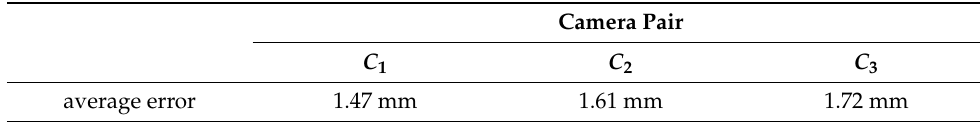
Figure 6. 3D reconstruction result and error. ( a ) reconstruction point cloud matched with the laser point cloud. ( b ) the corresponding point distance error maps, the units in the diagram are in mm. Table 4. The average error for each single